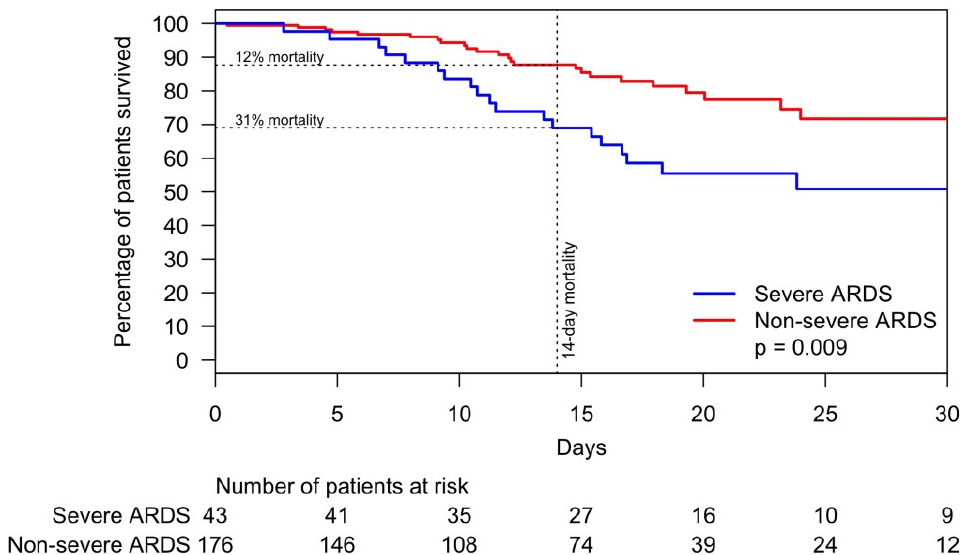
Figure 5. Time to mortality of patients with COVID-19 pneumonia within 28 days by severe and non-severe ARDS. Abbreviations: ARDS, acute respiratory distress syndrome; COVID-19, coronavirus disease 2019.